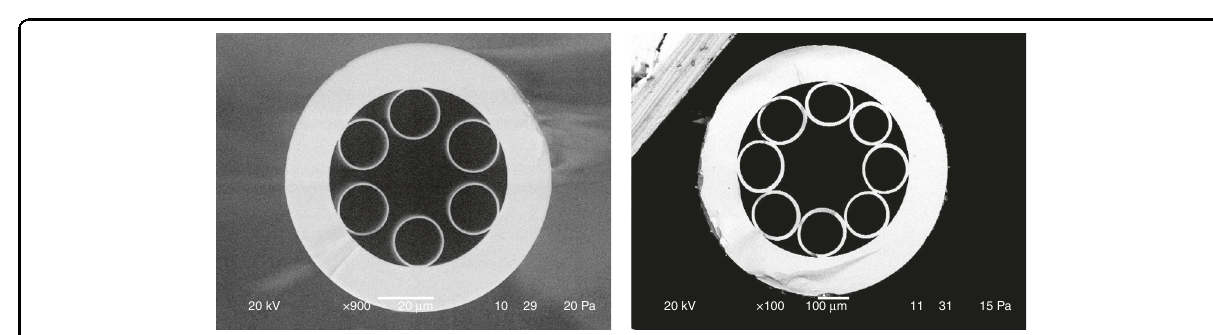
Fig. 2 Cross - sections of the negative curvature hollow core fi bers made of silica glass (left) and chalcogenide glass (right). The fi bers were fabricated at Dianov Fiber Optics Research Center.